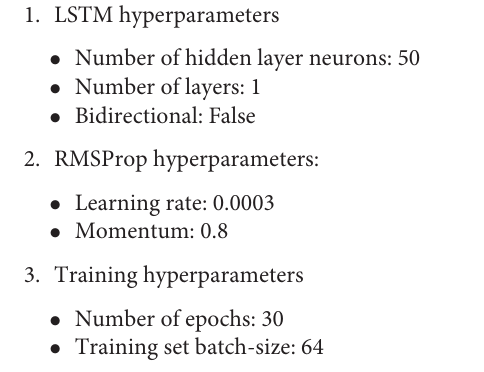
TABLE 1 | Evaluation of the LSTM-NN model and the persistence model with the metrics from section 2.3.2. Forecasting